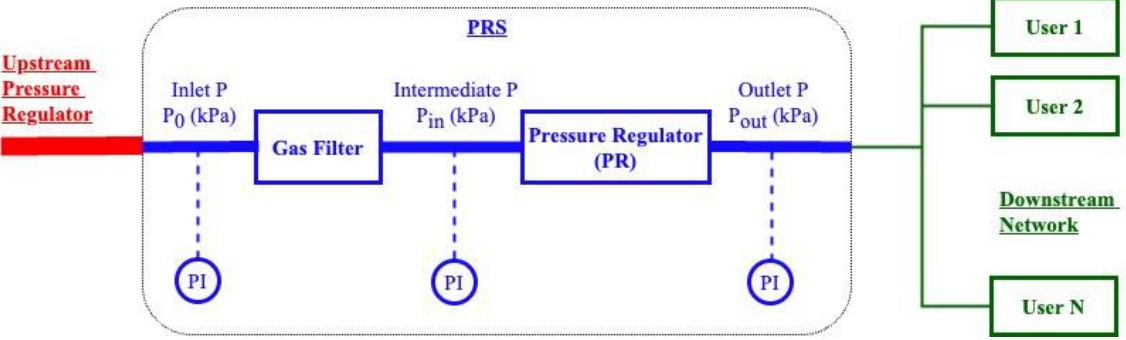
Figure 1. An overview of a PRS (gas filter and PR) with a downstream network.